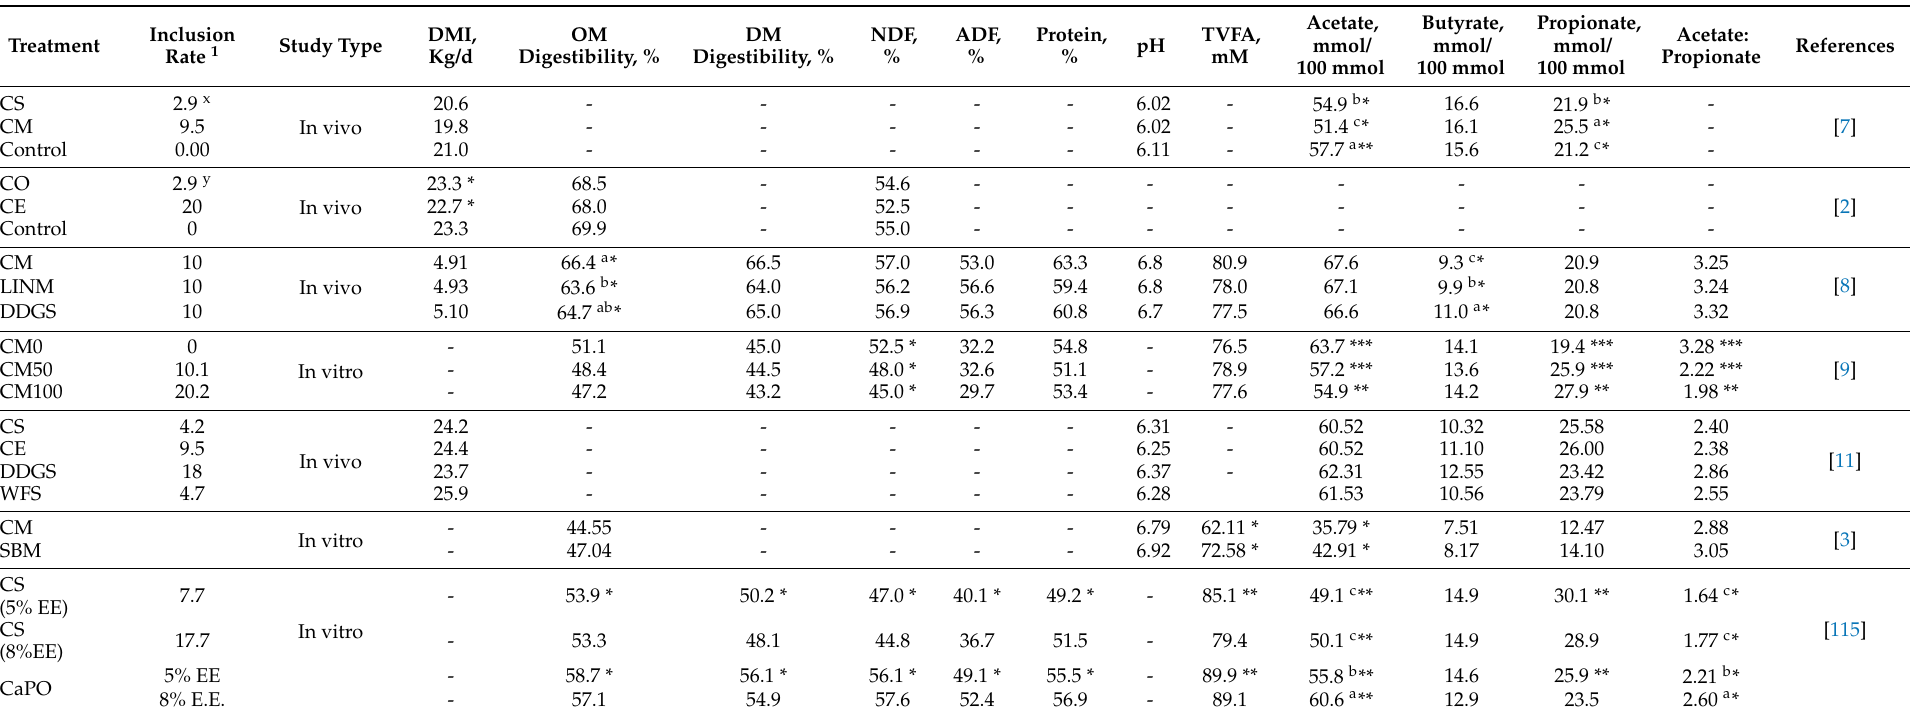
Table 7. Effect of the Camelina seed and its byproducts on feed intake, rumen digestibility and VFAs production in dairy